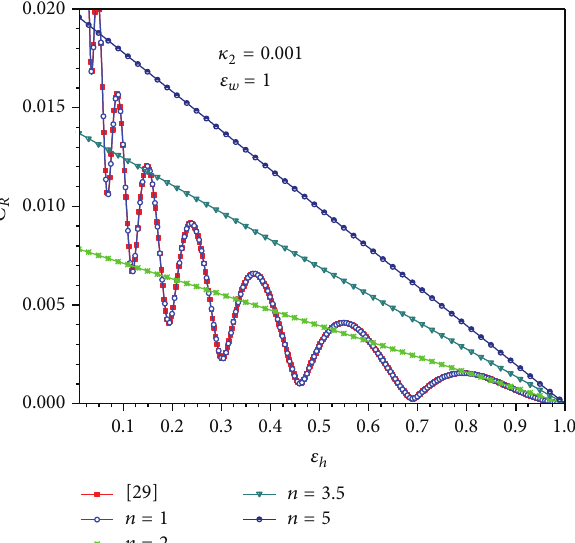
Figure 5: Reflection coefficient as a function of the dimensionless parameter 𝜀 ℎ , for waves propagating on a depth with transitions 𝑛(= 1 , 2 , 3 . 5 , 5 ) with 𝜀 𝑤 = 1 and 𝜅 2 = 0 .